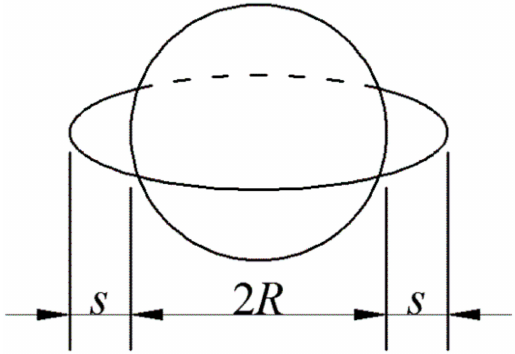
Figure 1. An annular flaw emanating from the spherical particle ( R is the particle radius and s is the flaw